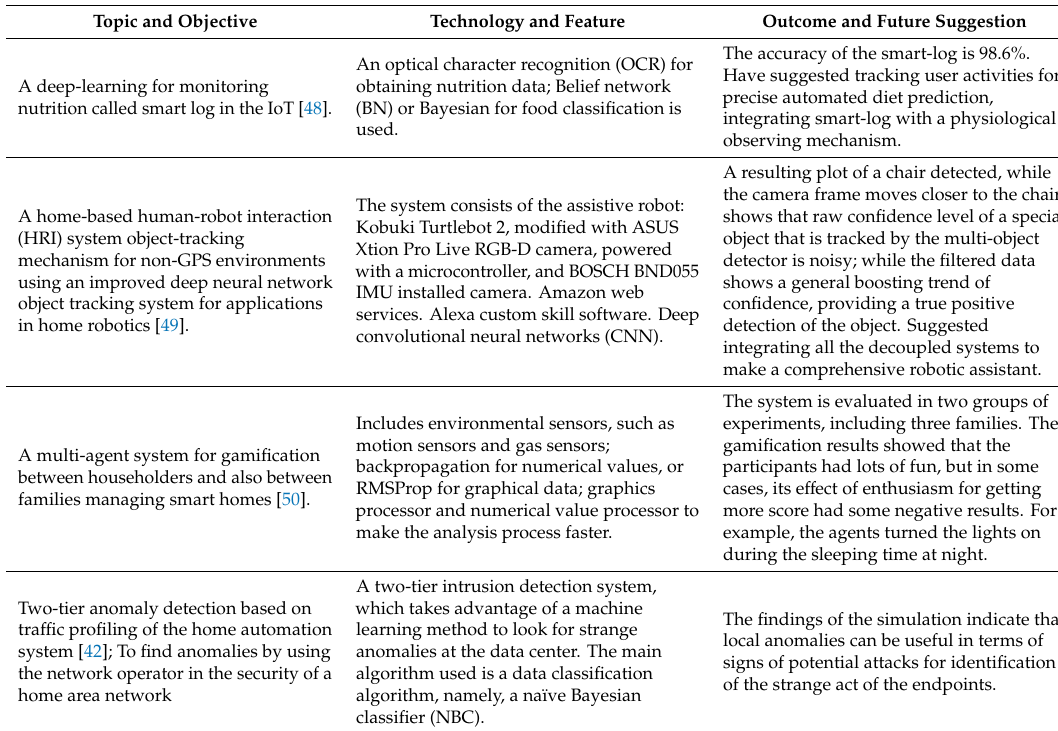
Table 5. Summary of selected papers focusing on the AI theme.